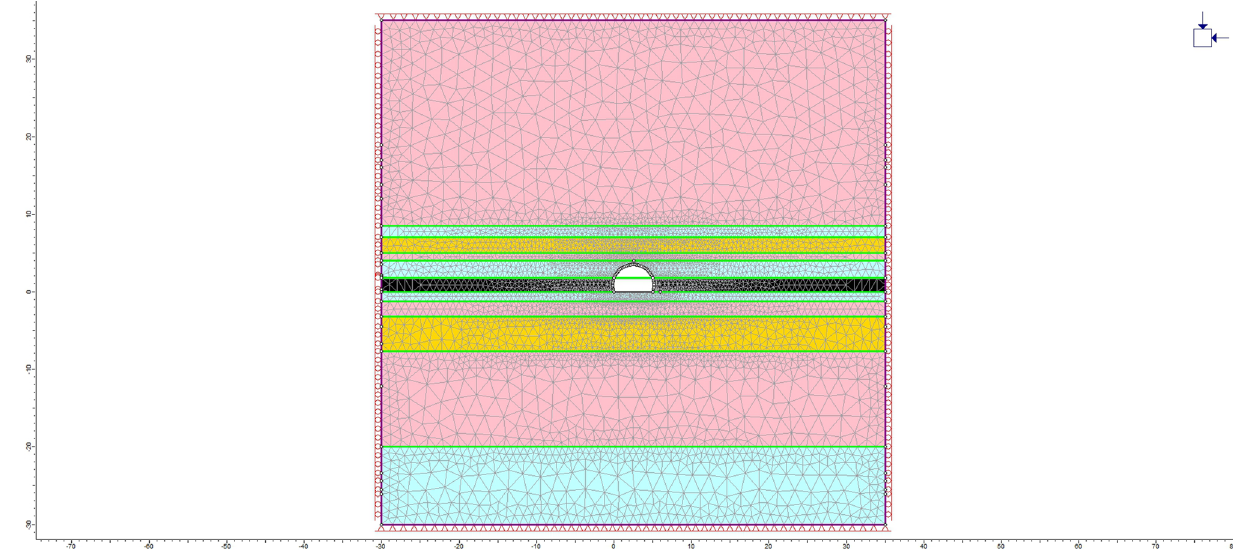
Fig. 10 Numerical